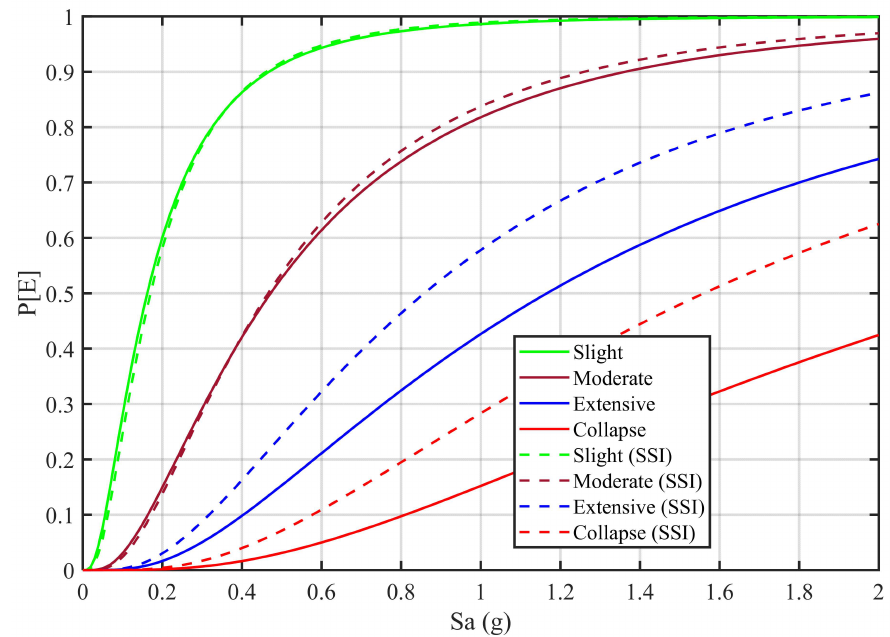
Figure 8. Fragility functions for RC elevated water tanks with smooth bars with and without considering soil structure interaction for empty reservoir